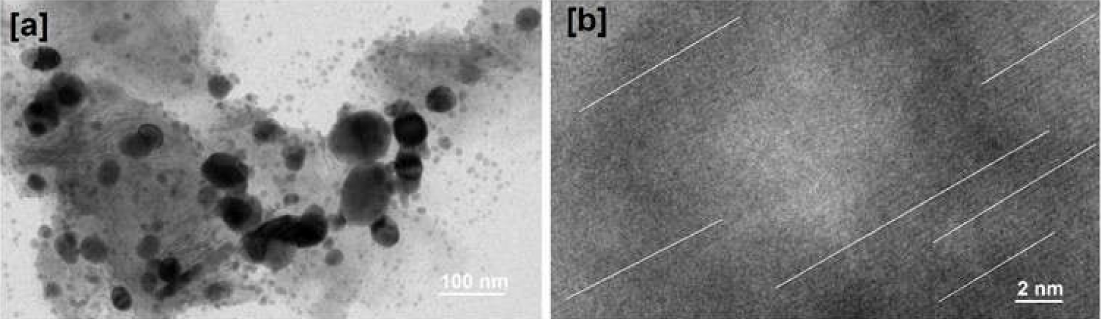
Figure 5. HR-TEM images of AgNCs at ( a ) bar scale of 100 nm, ( b ) bar scale of 2